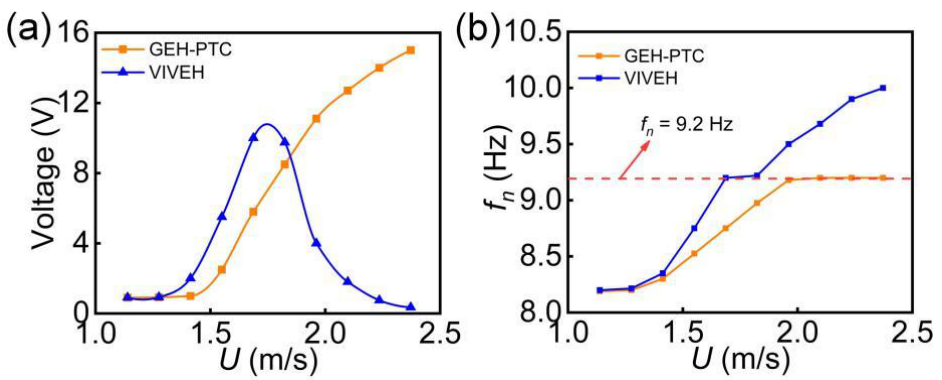
Figure 4. Experimental comparison of the GEH-PTC and the vortex-induced vibration energy harvester (VIVEH): ( a ) output voltage; ( b ) vibration frequency.